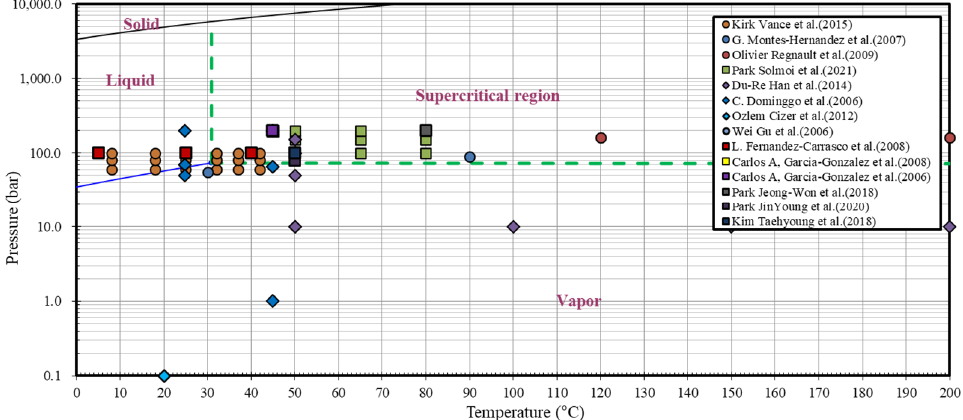
Figure 1. Temperature–pressure conditions reported in the current literature on supercritical CO 2 mineral carbonation.